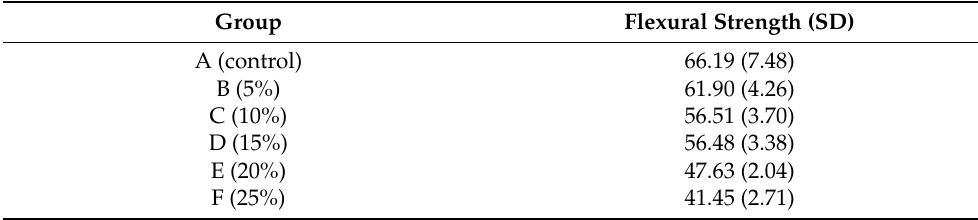
Table 2. Flexural strength for self-cure PMMA with various Gantrez concentrations ( n = 12).